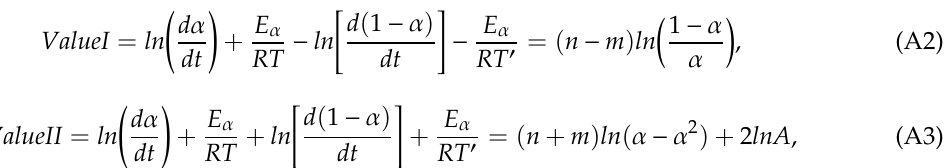
Figure A3. Curves of ln [Af( α )] vs. ln(1 ‐α ) at 5 °C/min via Friedman method.